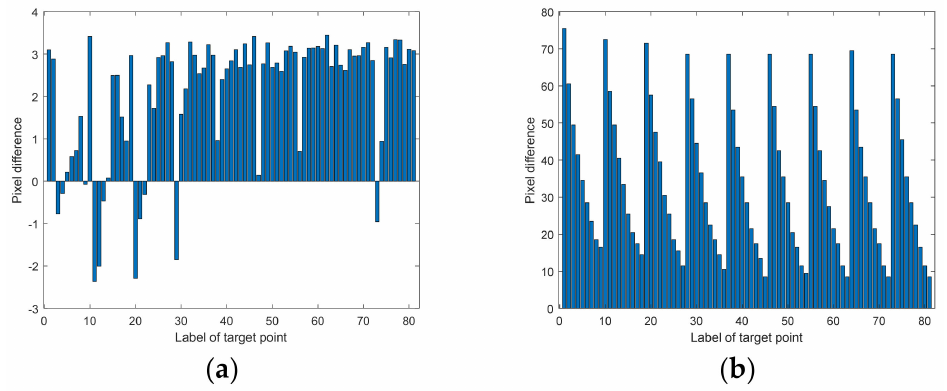
Figure 12. The pixel difference of each point: ( a ) pixel difference between the actual target position and simulated target position; ( b ) pixel difference between the ideal target position and actual target